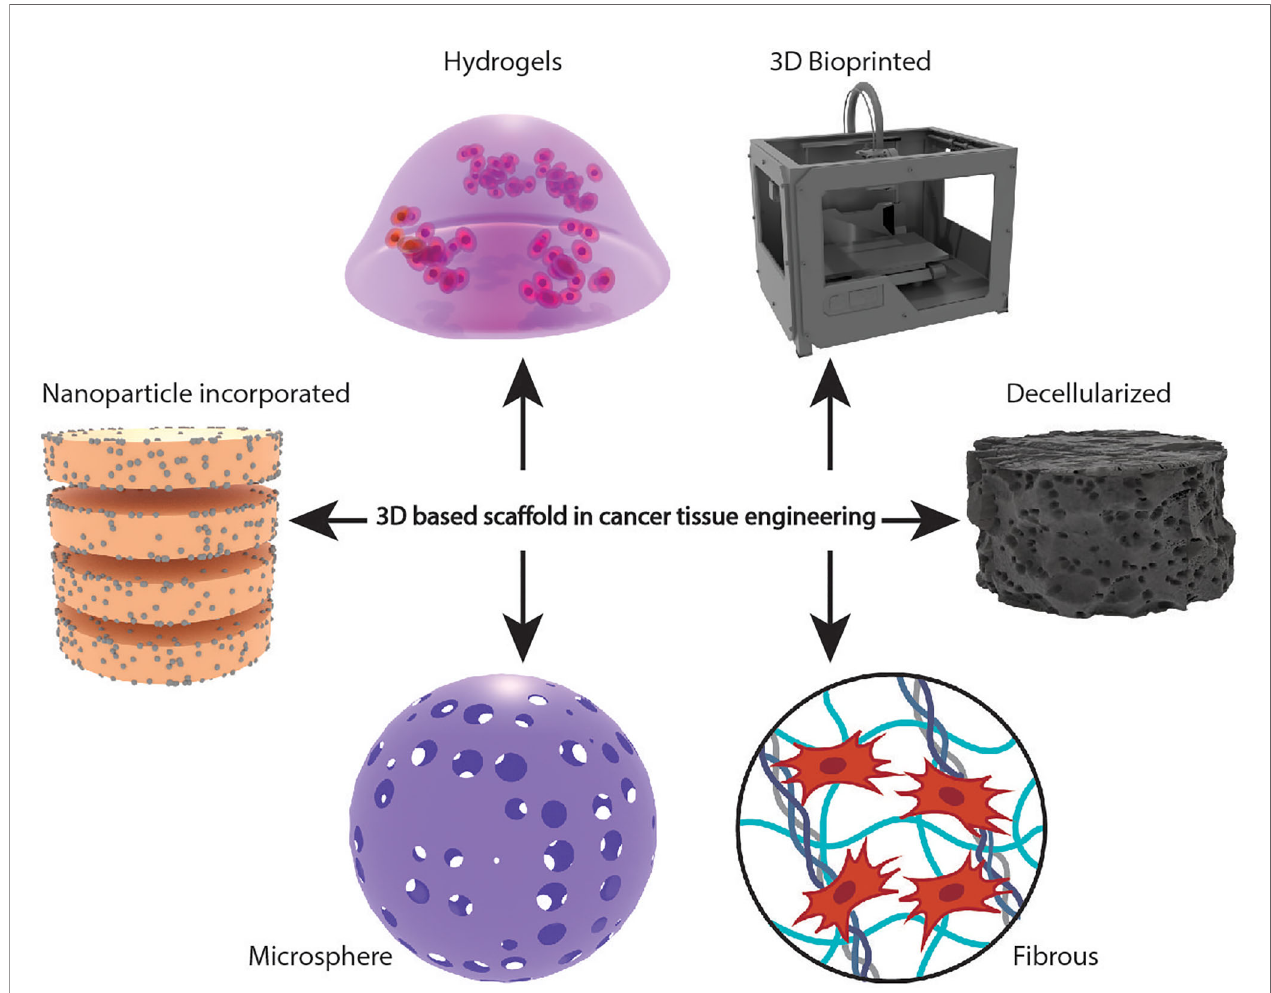
FIGURE 1 | Schematic representation of different types of scaffold-based 3D cellular models in cancer tissue